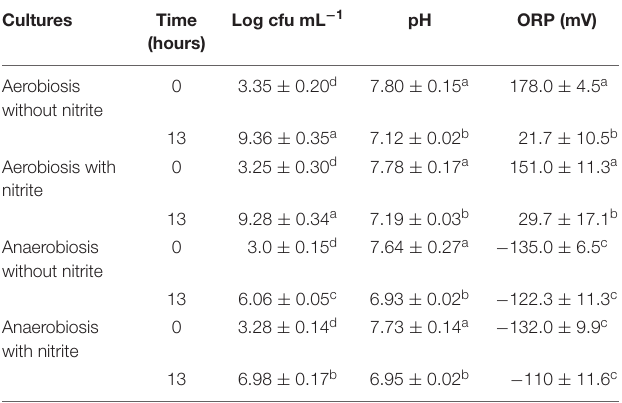
Each value represents the average ± standard deviation (n = 3). Means of each sample with same superscript letters in column do not differ significantly (P >